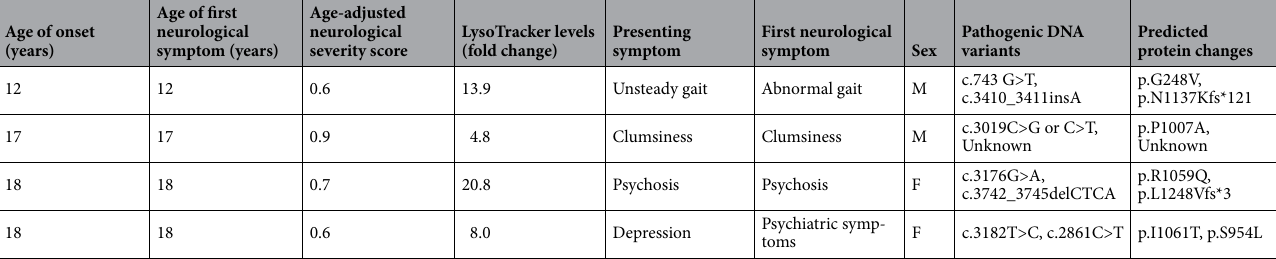
Table 1. NPC1 patient demographics. *Part of a sibling pair. **Negative values indicates age of onset in utero. † Subsequently received a liver transplant.